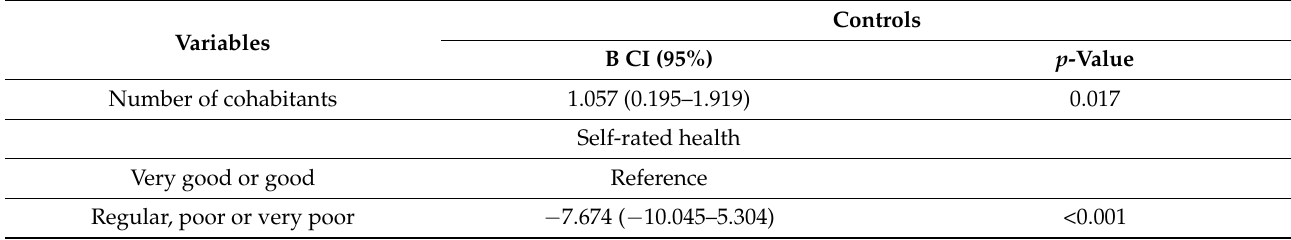
Table 4. Factors associated with better SMILE-C scores in the control